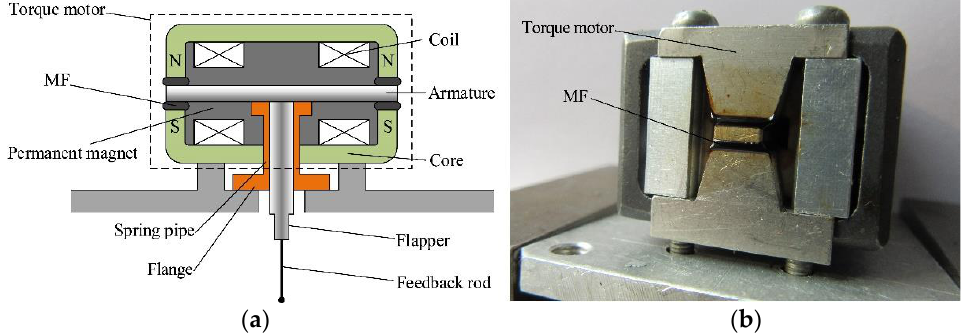
Figure 1. Construction and photograph of armature assembly in a hydraulic servo valve with MF. ( a ) Construction; ( b ) photograph.